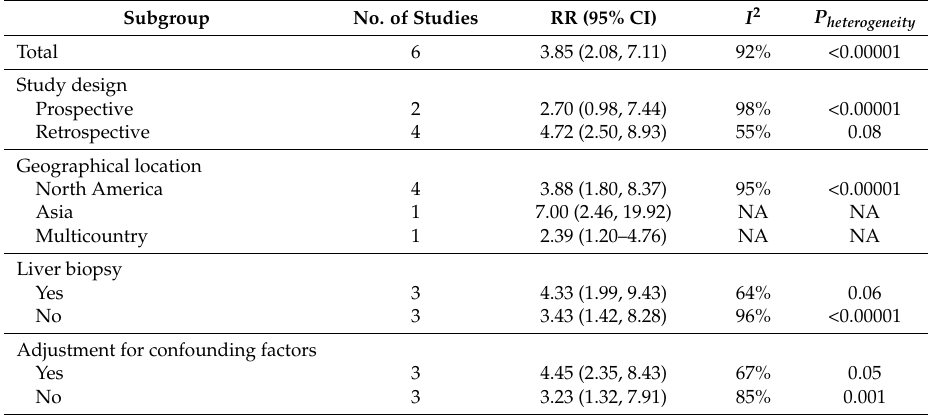
Table 2. Subgroup analysis of the six studies included in the meta-analysis of NFS and mortality. Subgroup No. of